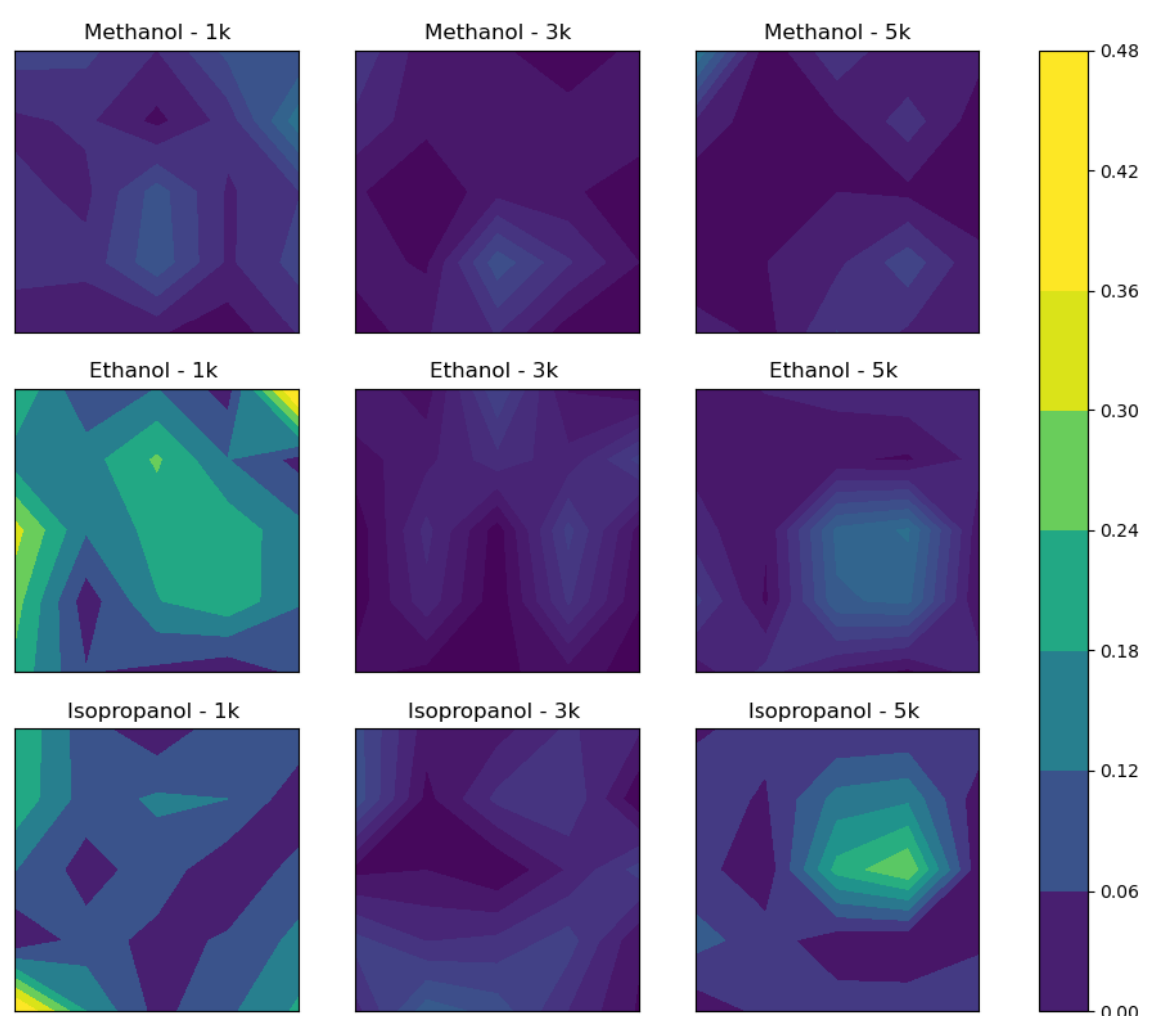
Figure 6. Contour plots constructed from the measurements made on films developed by 25% solvent additions at the specified RPM. A selected data set from Figure 3.